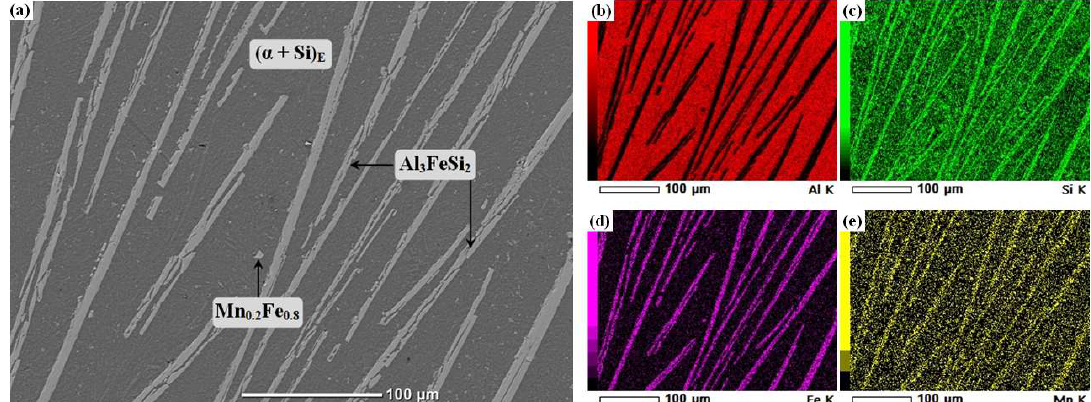
Figure 13. ( a ) Backscattered electron image of AlSiFe with 1 wt. % Mn alloy. Elemental mapping of ( b ) aluminum, ( c ) silicon, ( d ) iron, and ( e ) manganese. ( α +Si) E =